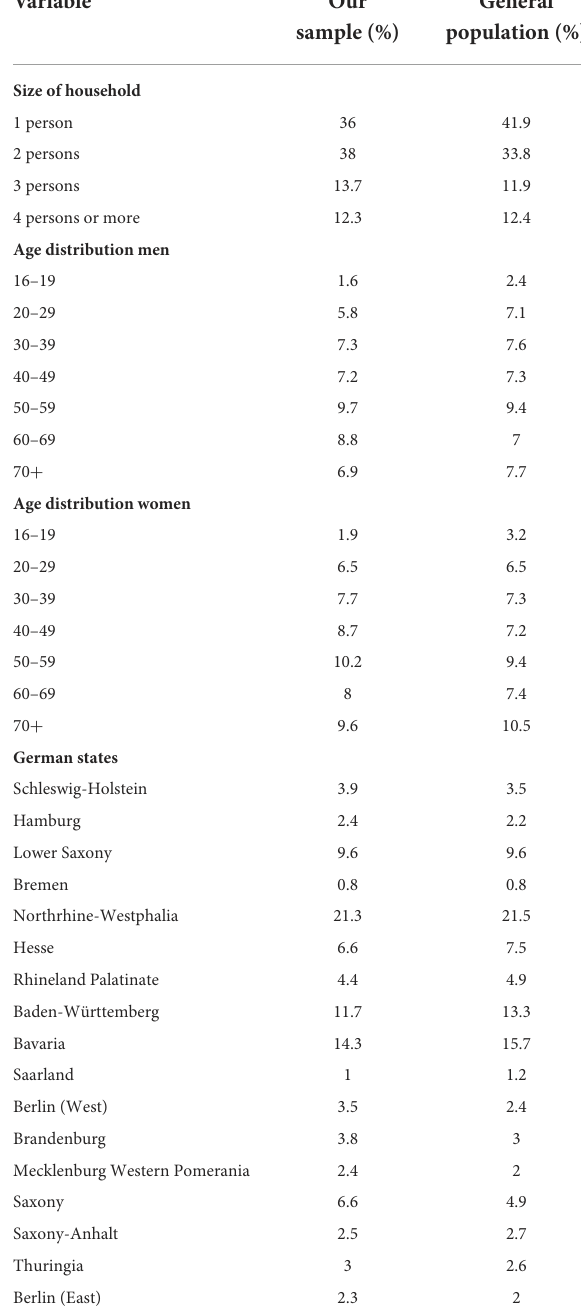
TABLE 1 Comparison of our sample with the General Population in